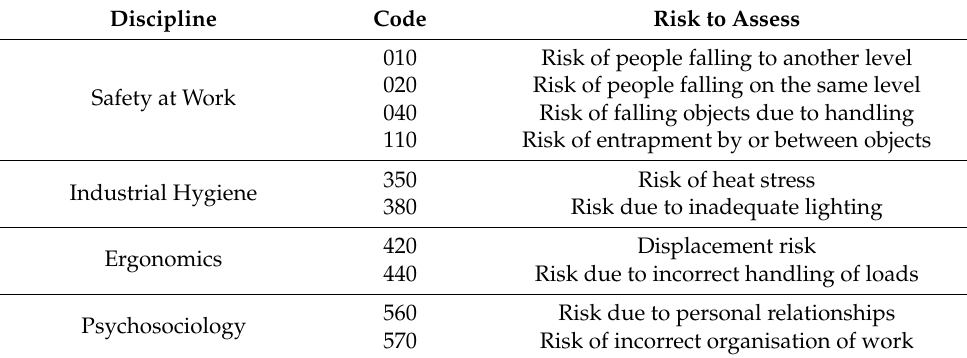
Table 7. Selected characteristic risks.